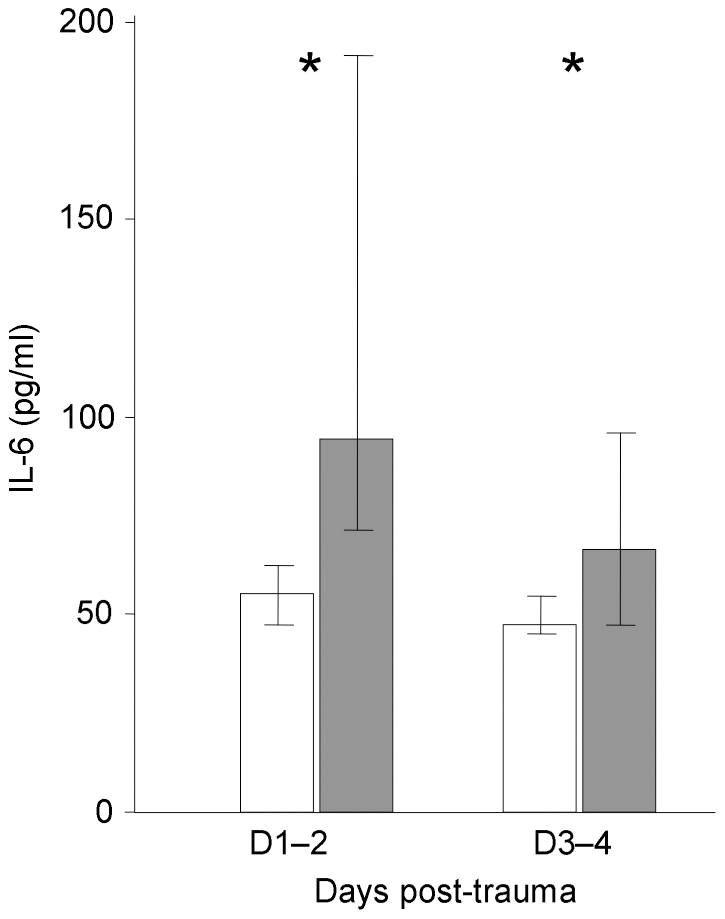
Time course of IL-6 concentration in trauma patients, with (gray) or without (white bars) sepsis.Results (pg/ml) are expressed as median [interquartile range] (Mann & Whitney U test, * p<.01). At days 1–2, IL-6 concentration was significantly higher in septic patients than in non-septic patients, as at days 3–4 but with less significance.